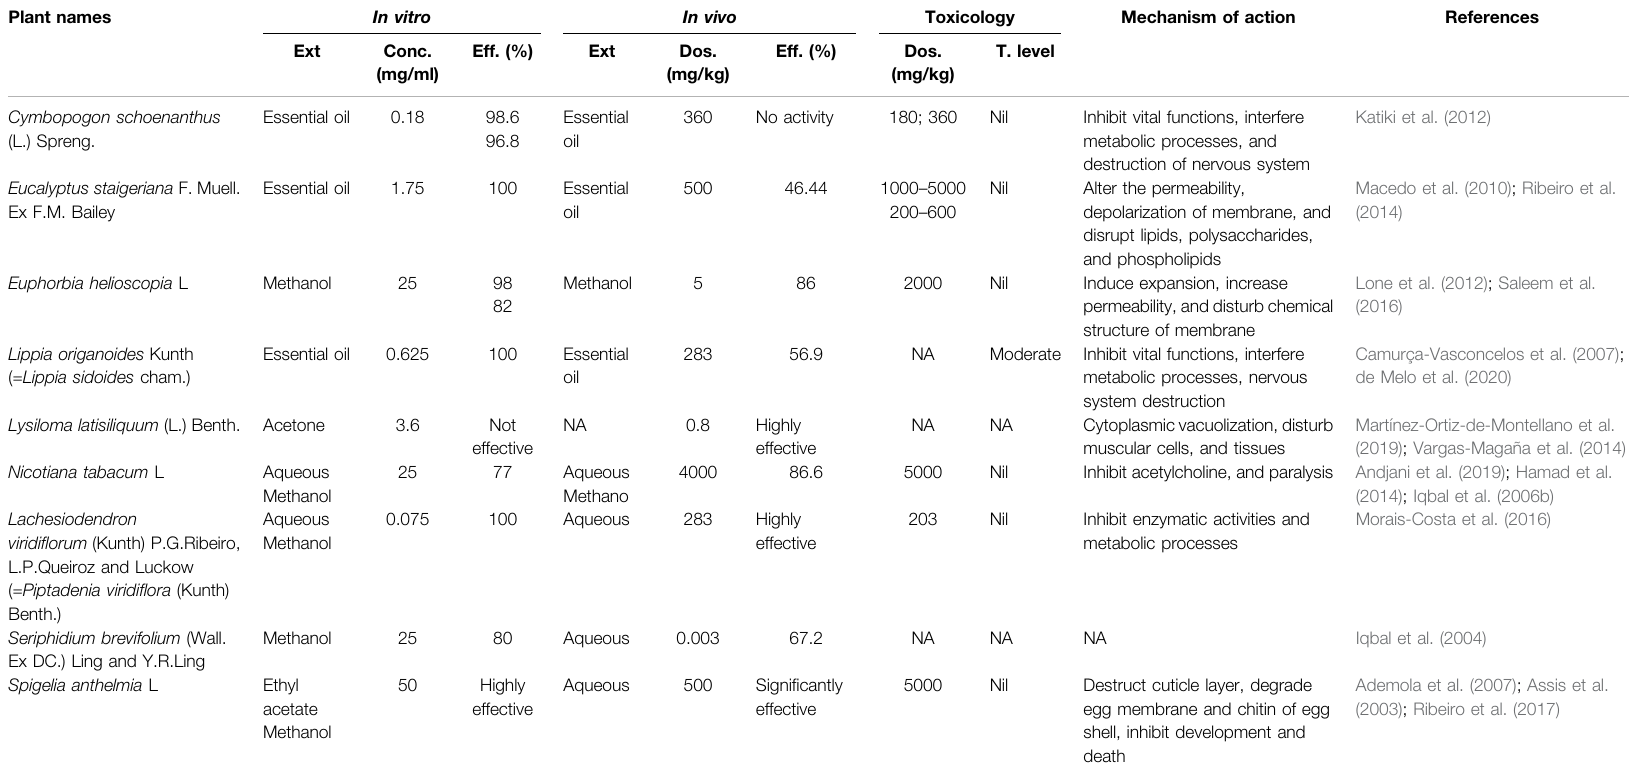
TABLE 2 | ( Continued ) Comparative analysis, toxicology, and mechanism of action of medicinal plants.